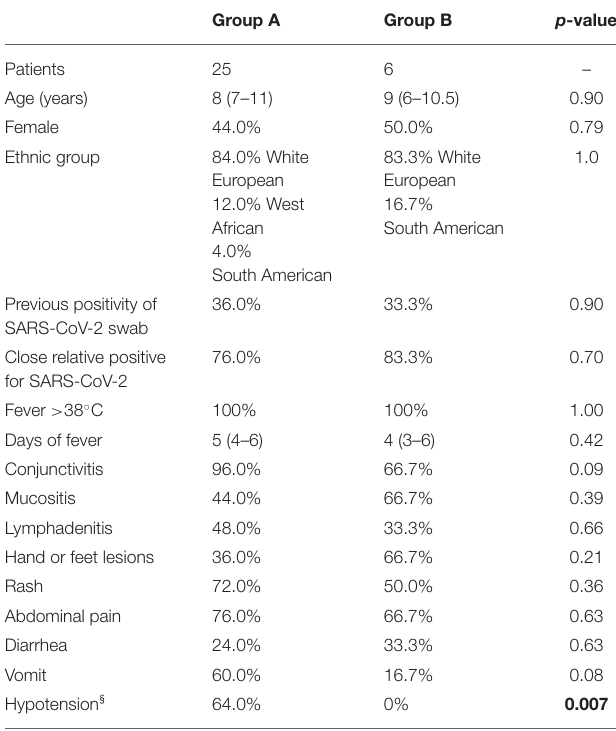
TABLE 1 | Demographic and clinical features of Group A and Group